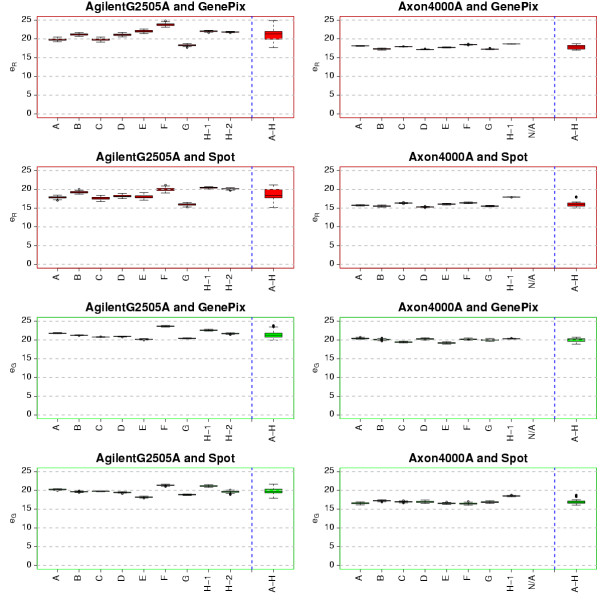
Bias estimated for each array and channel on both scanners Estimated biases ec for each array and for all arrays together from the Agilent scanner (left column) and the Axon scanner (right column). The top four graphs are for the red channel and the bottom four are for the green channel. For each channel the top two are estimates based on signals quantified by GenePix and the bottom two on signals quantified by Spot. See also Table 2 & 3.